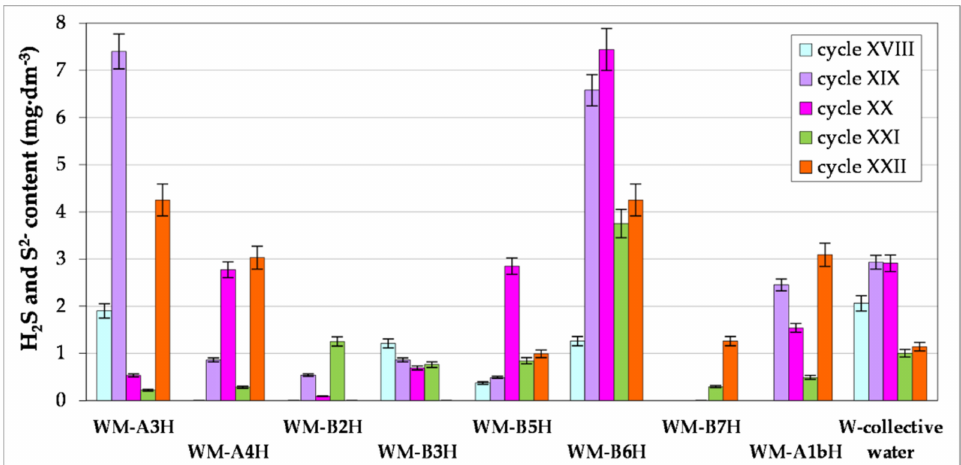
Figure 2. Content of hydrogen sulphide and sulphides in formation waters of selected Wierzchowice UGS wells; cycles XVIII-XXII (average values from three series for every well in subsequent